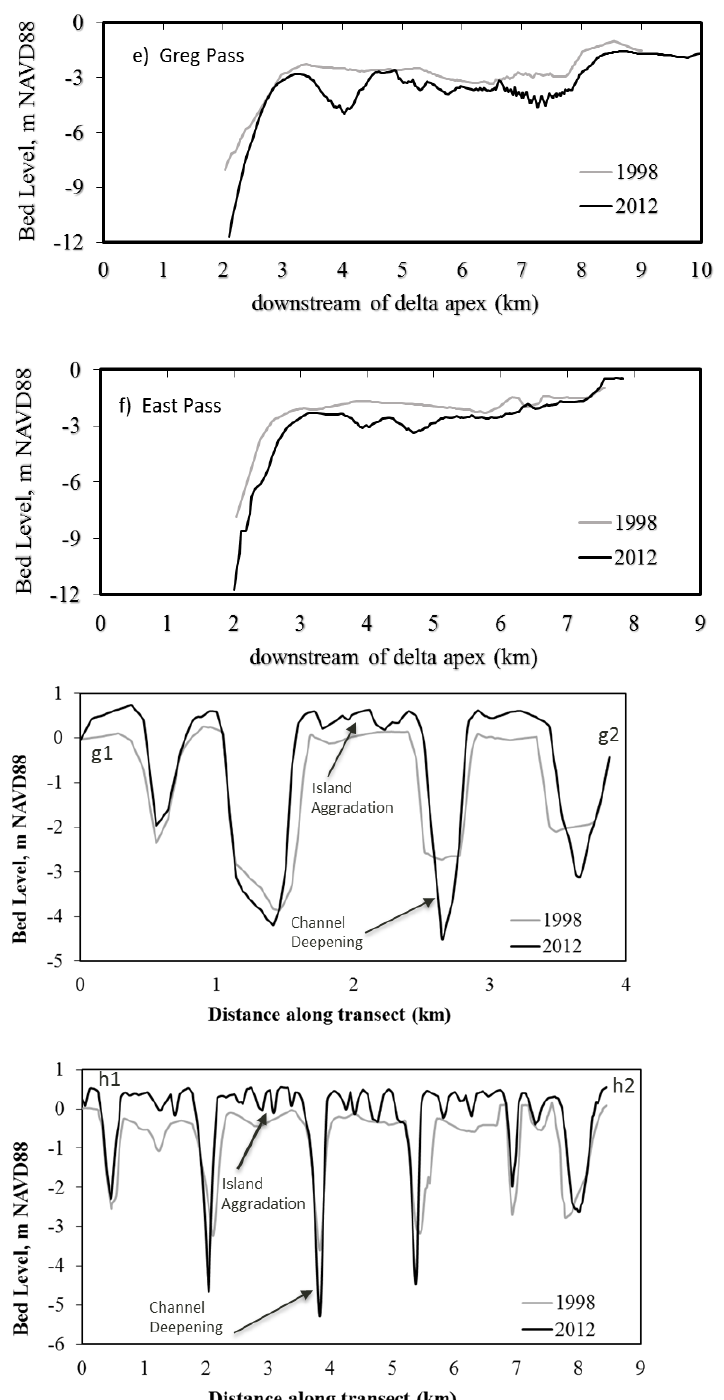
Figure 12. Simulated morphological changes in the Wax Lake Delta Channels over 15-year period (1998–2012). ( a ) Aerial map showing location of longitudinal and cross-section transects. ( b – f ) Longitudinal transects for five distributary channels. Distances are with respect to the delta apex. ( g1 – g2 , h1 – h2 ) Transects passing through islands and channels showing channel incision, channel narrowing due to edge accretion, and island aggradation after 15 years.